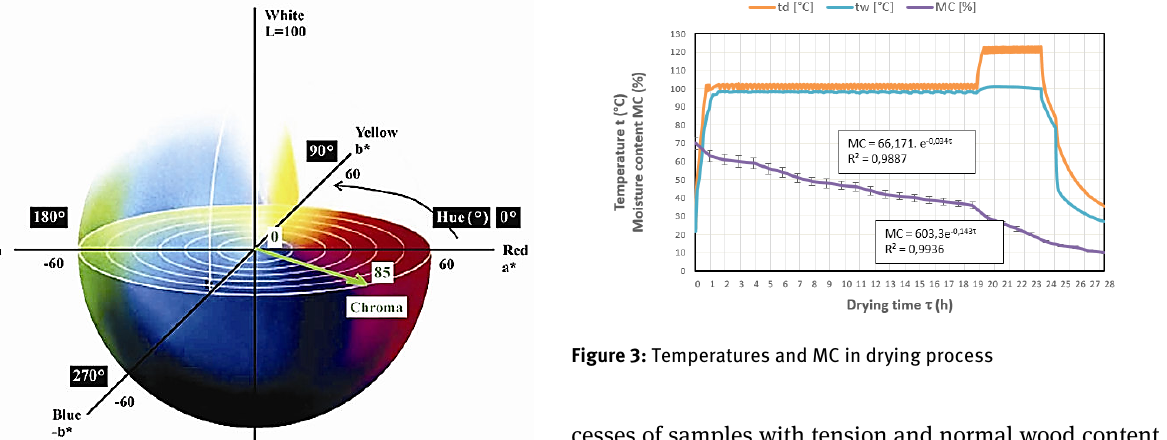
cesses of samples with tension and normal wood content were balanced and have not been influenced by variability of initial moisture and angle of growth rings as well. Table 1: Moisture content and drying time tension and normal sam-